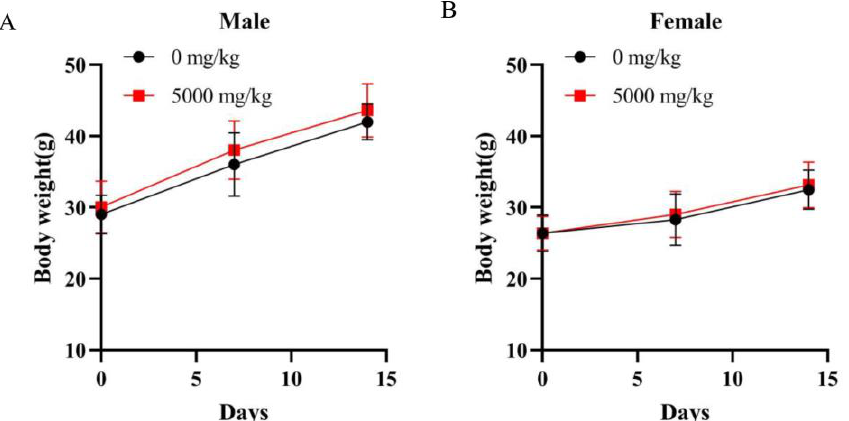
Figure 6. Body weight changes of mice in the single-dose acute oral toxicity study: ( A ) male; ( B ) female. Data are presented as mean ± SD ( n = 10/sex/group).